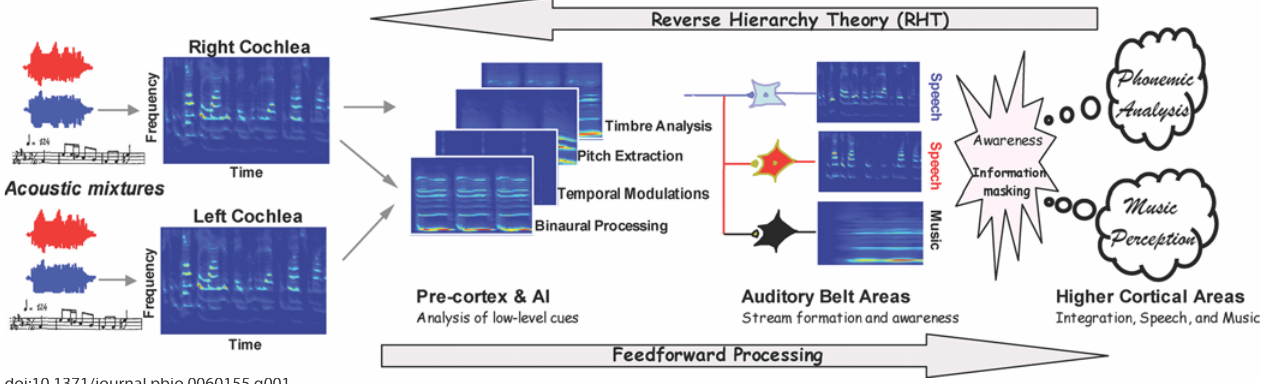
Figure 1 . Bottom-Up Flow and Top-Down Control of Information in the Auditory System Schematic of the bottom-up feed-forward flow of auditory analysis and the top-down cognitive influences (RHT) that give rise to auditory perception and awareness. From left to right, natural acoustic scenes usually contain mixtures of multiple speakers (red and blue signals) and music. Low-level cues embedded in the cochlear spectrograms from the right and left ears are analyzed and combined in several precortical and primary auditory cortical (A1) stages. Neural correlates of consciously perceived streams of speech and music would emerge in the auditory belt areas beyond A1. In complex realistic scenes, ambiguous (“informationally masked”) speech and musical streams are resolved through top-down influences described by the